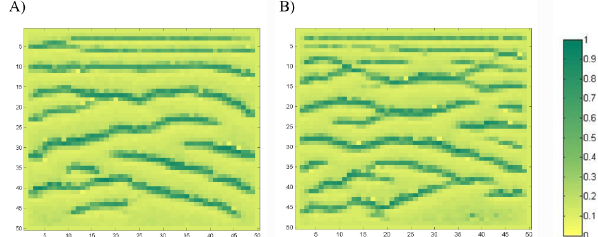
Fig. 21. Effect of spatially variable reflectance on pattern forma- tion. (A) Uniform reflectance, that is, constant albedo. (B) Spatially variable albedo.